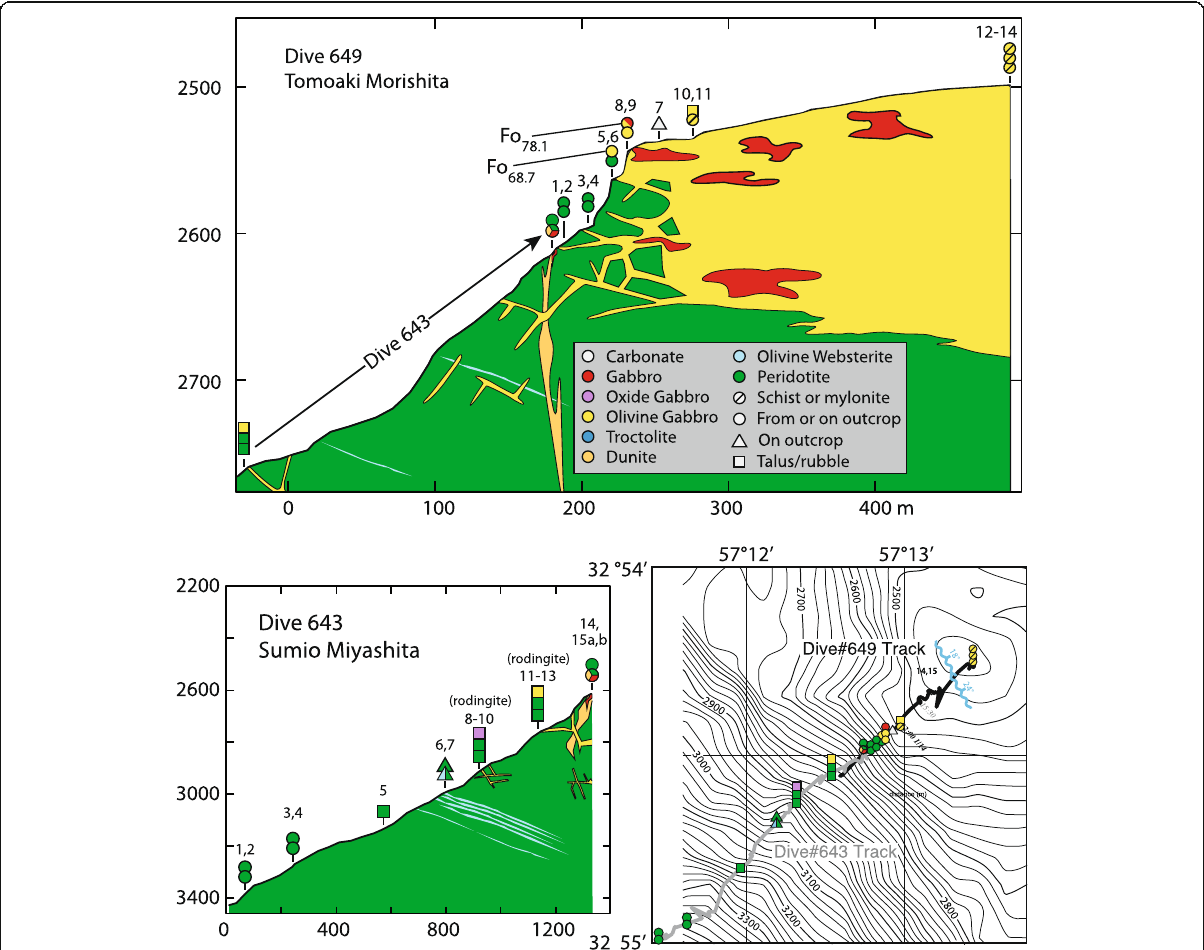
Fig. 44 Interpretive cross-sections and plan view for Shinkai 6500 Dives 643 and 649 (Fig. 3) across the gabbro-mantle contact. Dive scientists were T. Morishita and S. Miyashita as indicated on the cross-sections. Blue streaks represent olivine websterite